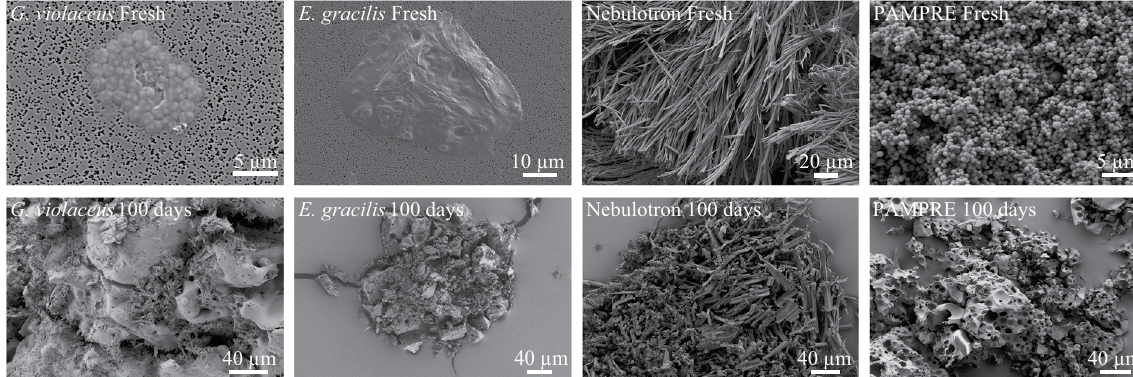
Figure 1. Evolution of fine-scale morphologies. SEM images of the organic and the corresponding residues of 100 day long advanced diagenesis experiments performed at 250 °C and 250 bars. Note that the morphology of Nebulotron has only slightly been degraded during the